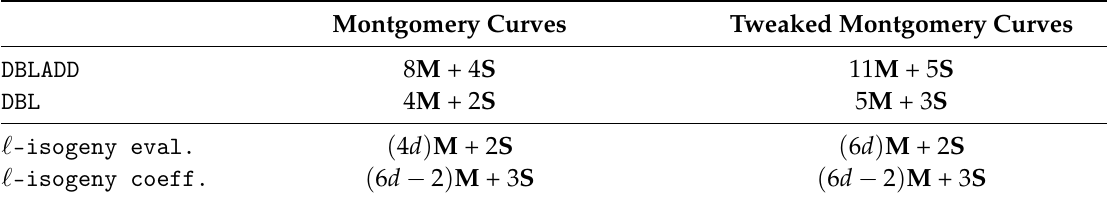
Table 1. Computational costs of lower-level functions on Montgomery and tweaked Montgomery